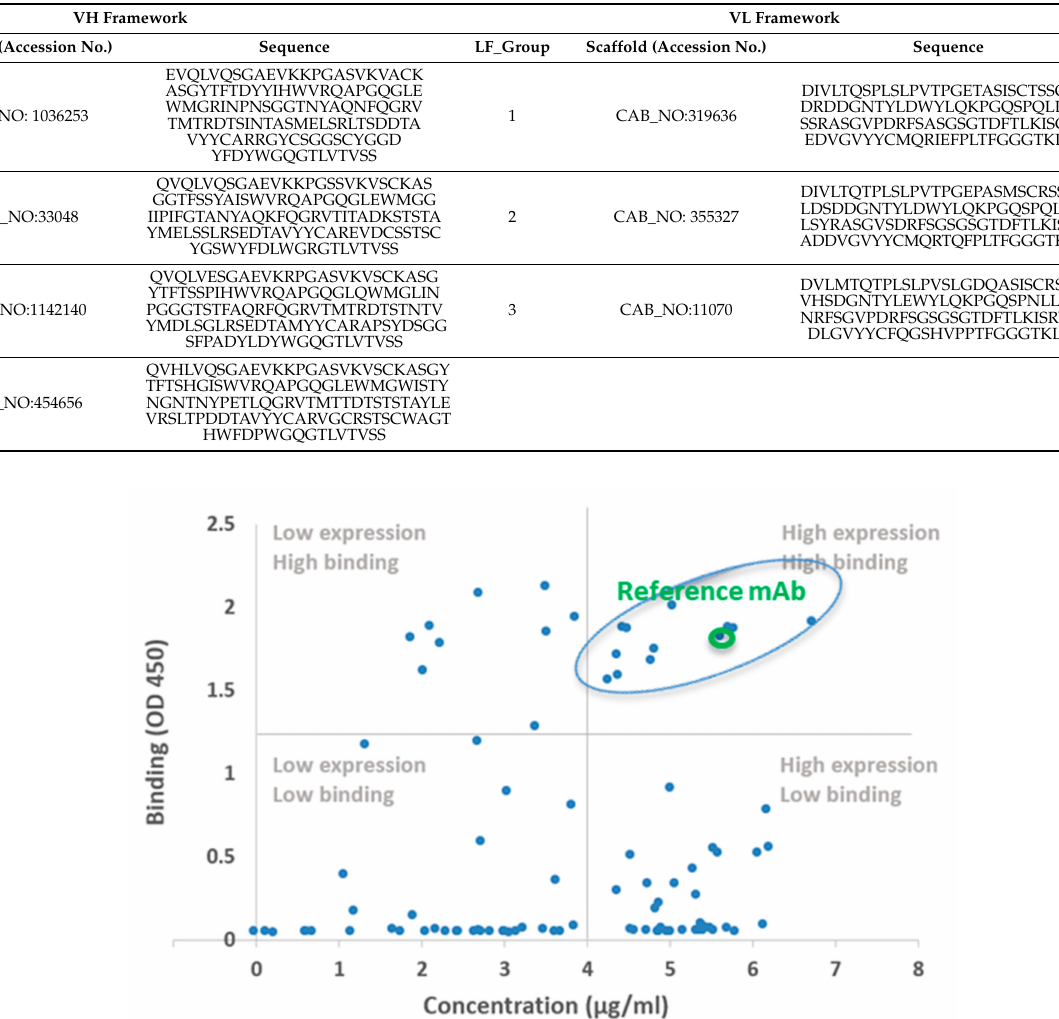
Table 2. Antibody frameworks selected for the shuffling process. For each framework, the internal accession id (CAB_NO) and group classification are provided.